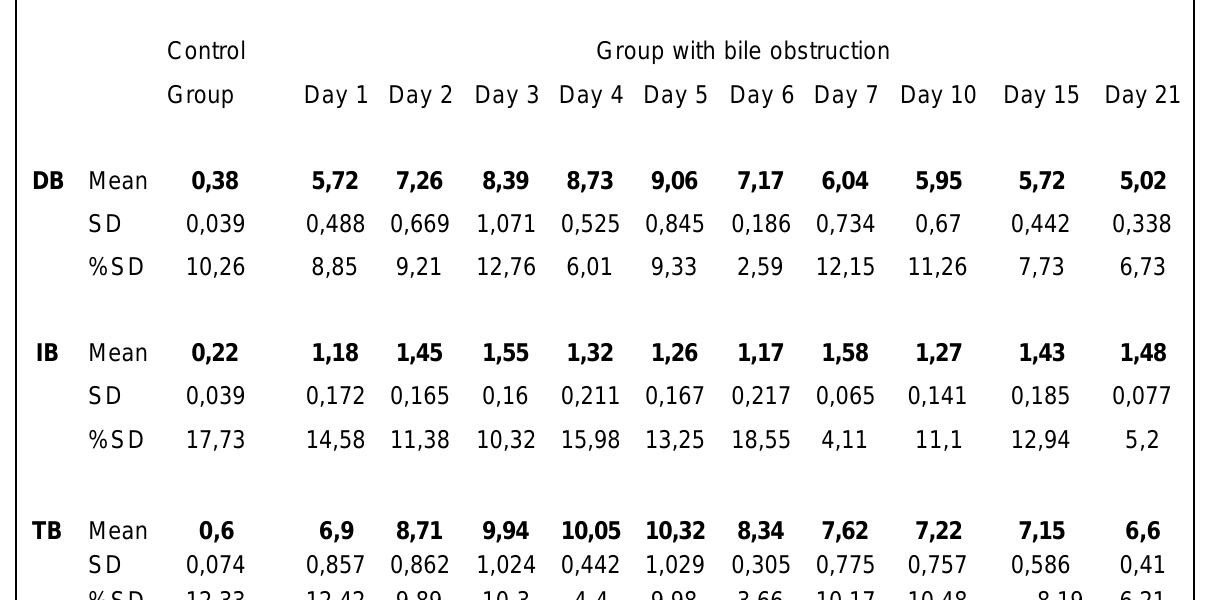
TABLE 1 – Mean plasma bilirubin concentration (mg/dl) and standard deviation obtained for the control group and for the experimental group on different days after bile duct